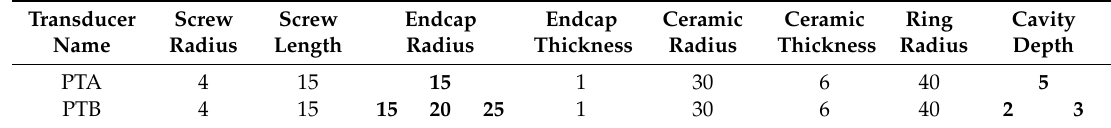
Table 2. Structural parameters of two piezoelectric transducers (mm)